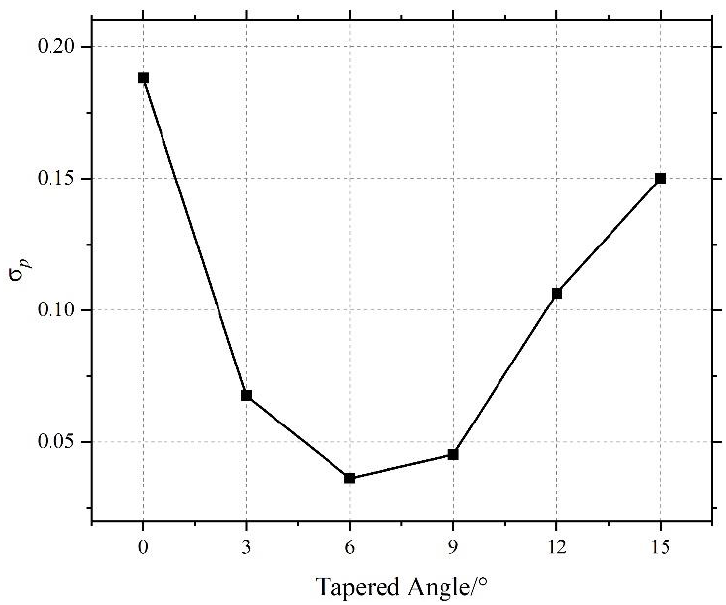
Figure 12. Standard deviation of the non-uniformity of each